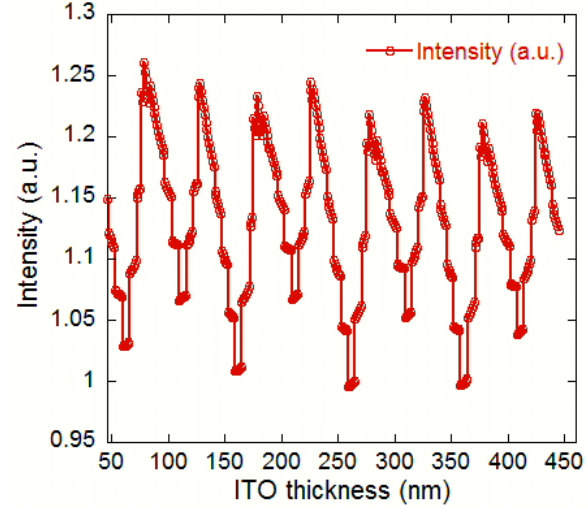
Figure 4. LED top output intensity as ITO thickness varies from 0 nm to 450 nm at 1 nm increments. Table 2. Light output intensities at the best, worst, and neutral ITO thicknesses. ITO Thickness Output Intensity (a.u.) % Improvement over ITO thickness Output Intensity (a.u.)